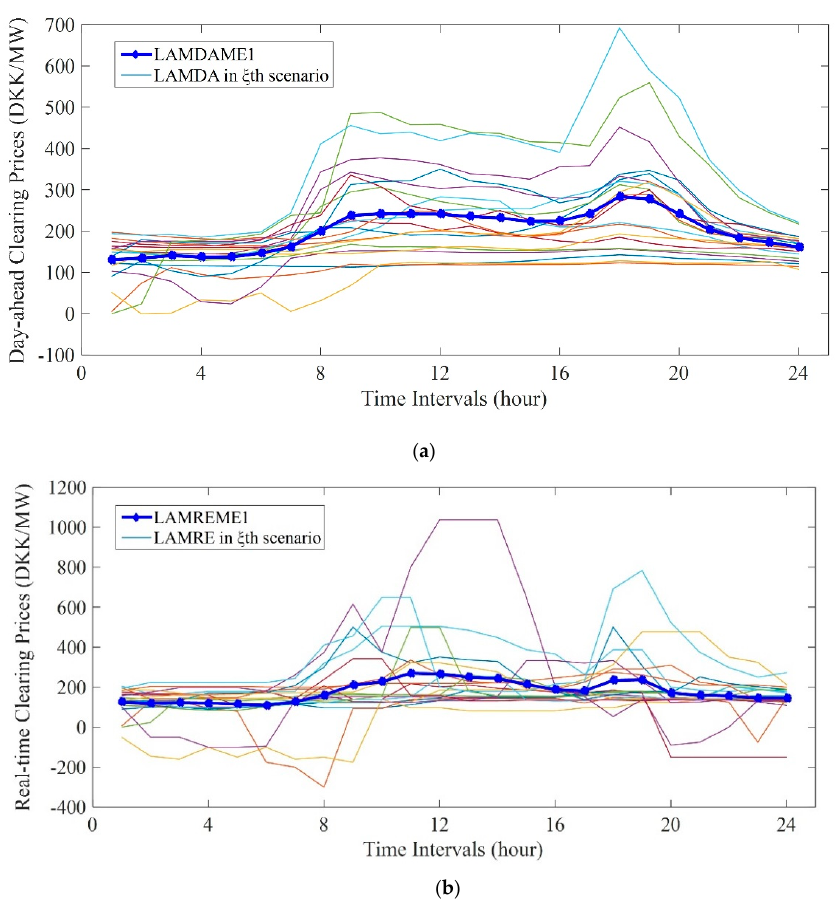
Figure A2. ( a ) Schematic diagram of EM clearing prices at day-ahead stage on the typical winter day; ( b ) Schematic diagram of EM clearing prices at real-time stage on the typical winter day.